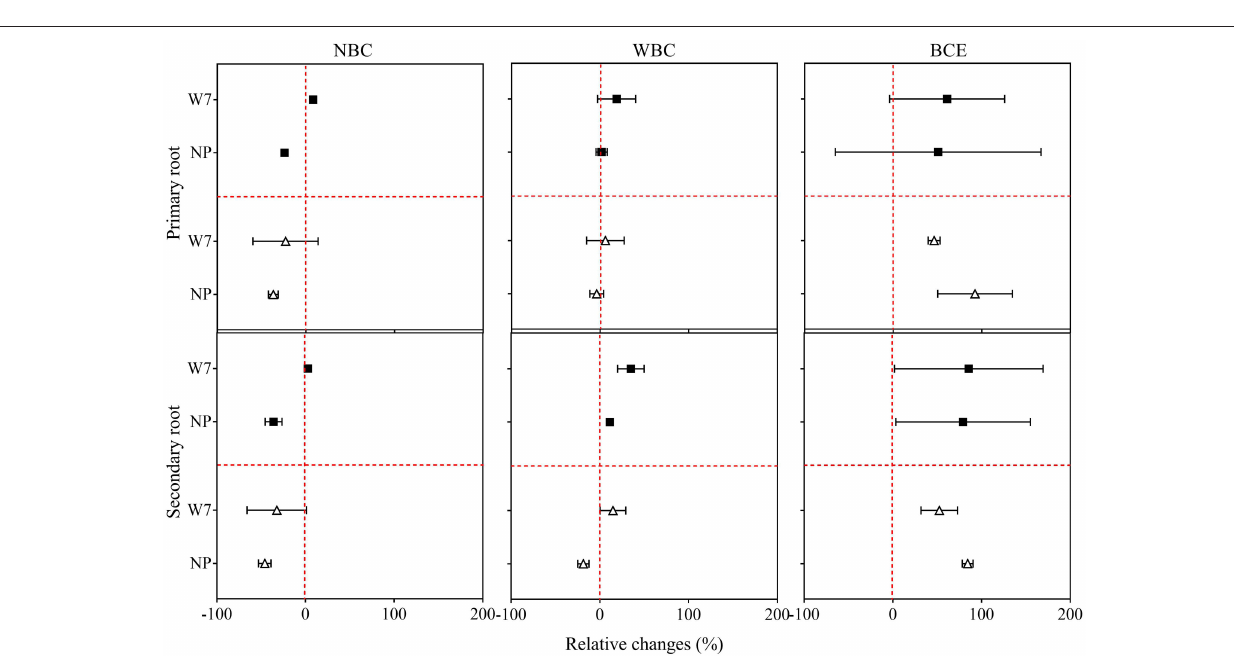
( Supplementary Table 5 ). As shown in Figure 3 , shoot nutrient contents of N, P, and K were all significantly elevated with BCE both at 0.01 and 0.05% dosages